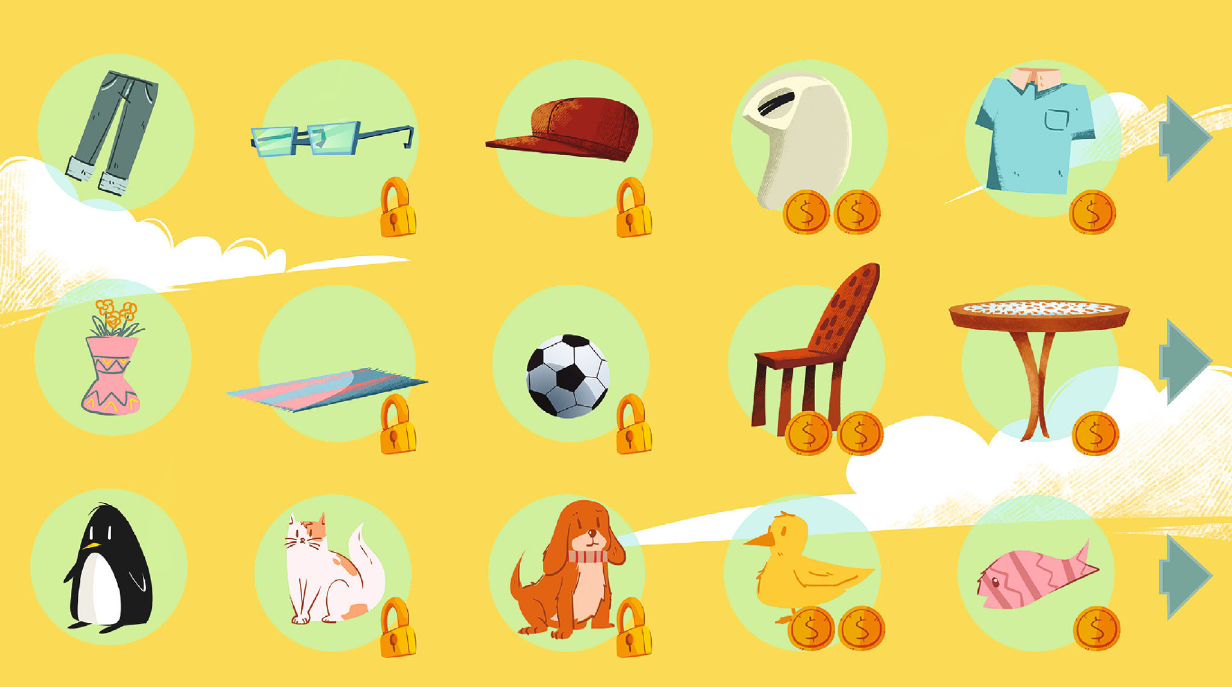
Figure 13: Shopping cart